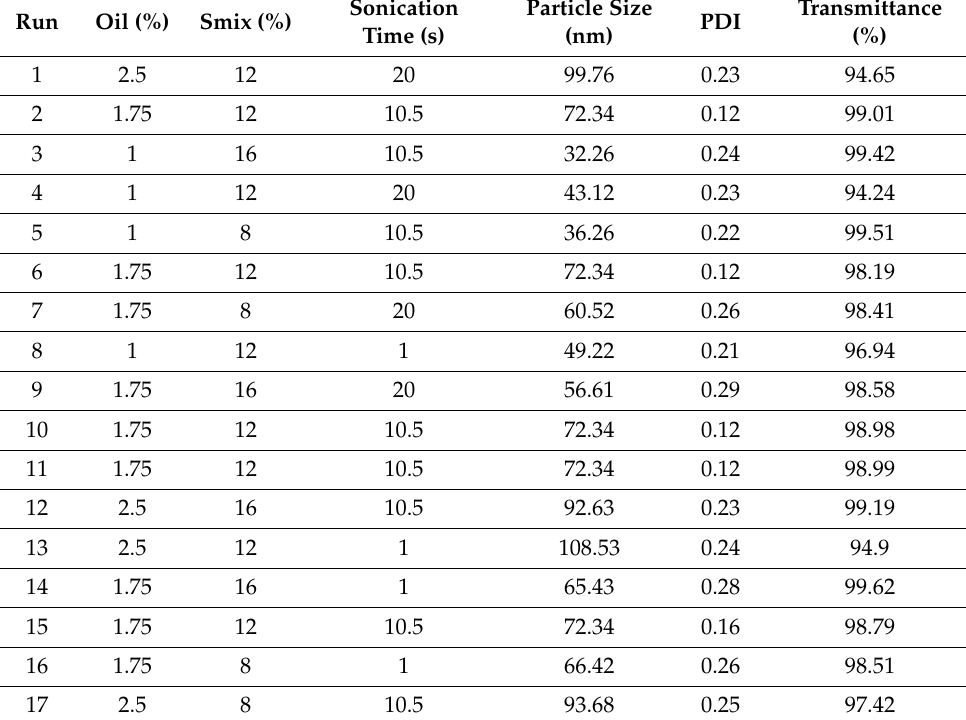
Table 2. BBD-based FTQ nanoemulsion with independent and dependent